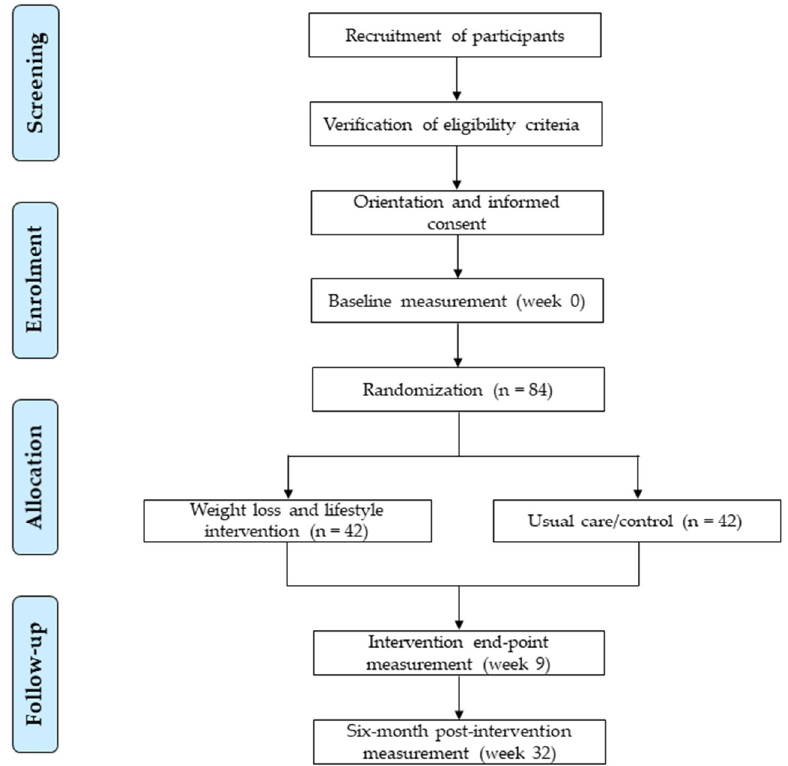
Figure 1. Flow diagram of the INTERAPNEA study participants.